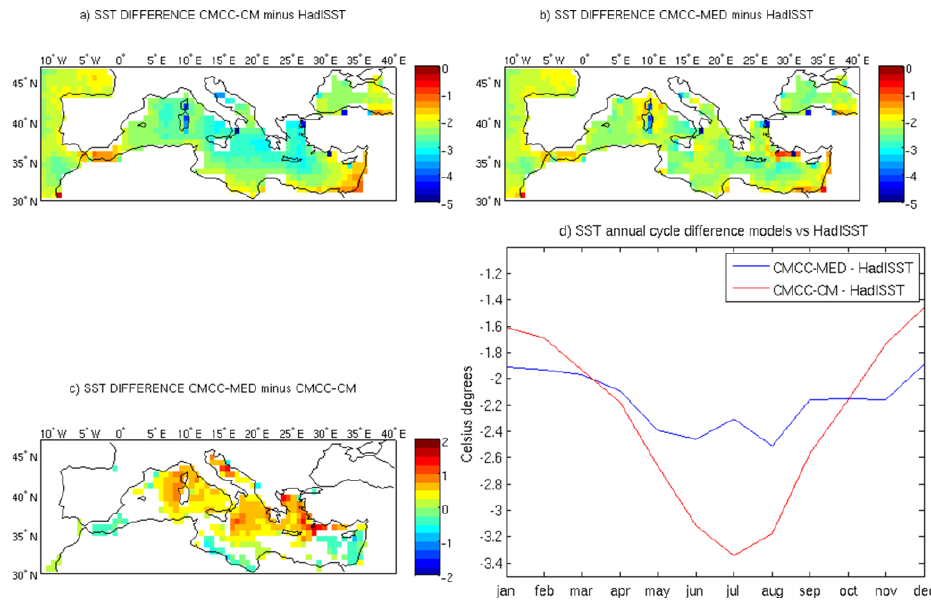
Fig. 1. Average SST bias in CMCC-CM (panel a ) and in CMCC-MED (panel b ) for the 1981–2008 period. Negative values indicate that both model simulations are colder than observations. Panel ( c ) shows the average SST difference between CMCC-MED and CMCC-CM (positive values in areas where CMCC-MED is warmer that CMCC-CM). Colored areas denote differences that are statistically significant at the 95% confidence level (a t test was used).Values according to color bars. Panel (d) shows the SST annual cycle difference between HadISST and CMCC-MED (blue curve) and CMCC-CM (red